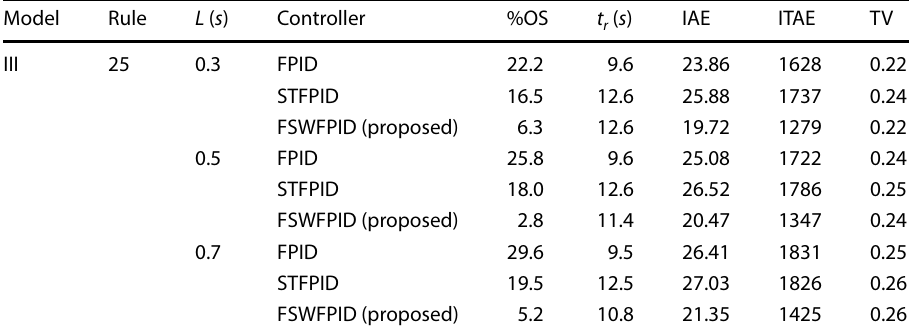
Fig. 14 Comparison among responses and control actions for Model III with FSMC using 49 rules during set point response and with load varia- tion for a L = 0.3 s, b L = 0.05